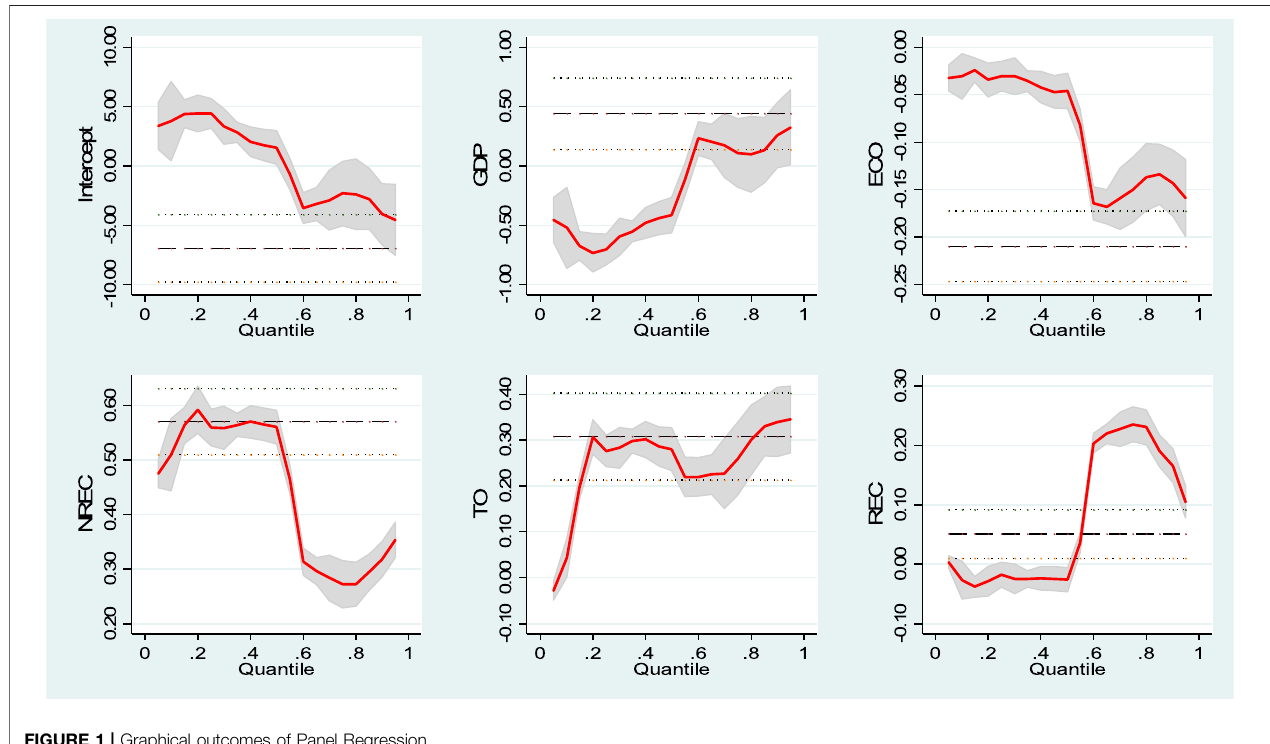
FIGURE 1 | Graphical outcomes of Panel Regression.